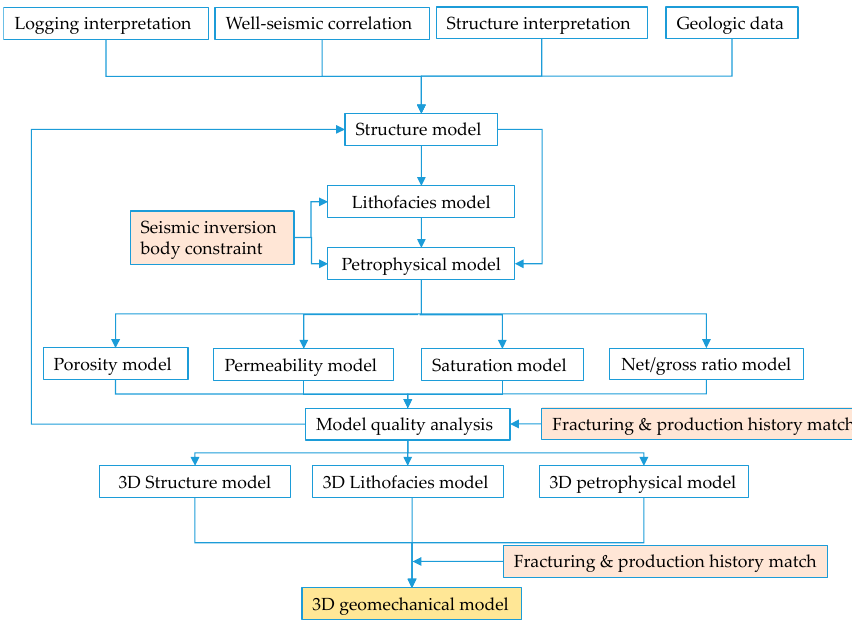
Figure 1. The overall workflow used to extract geomechanical model.